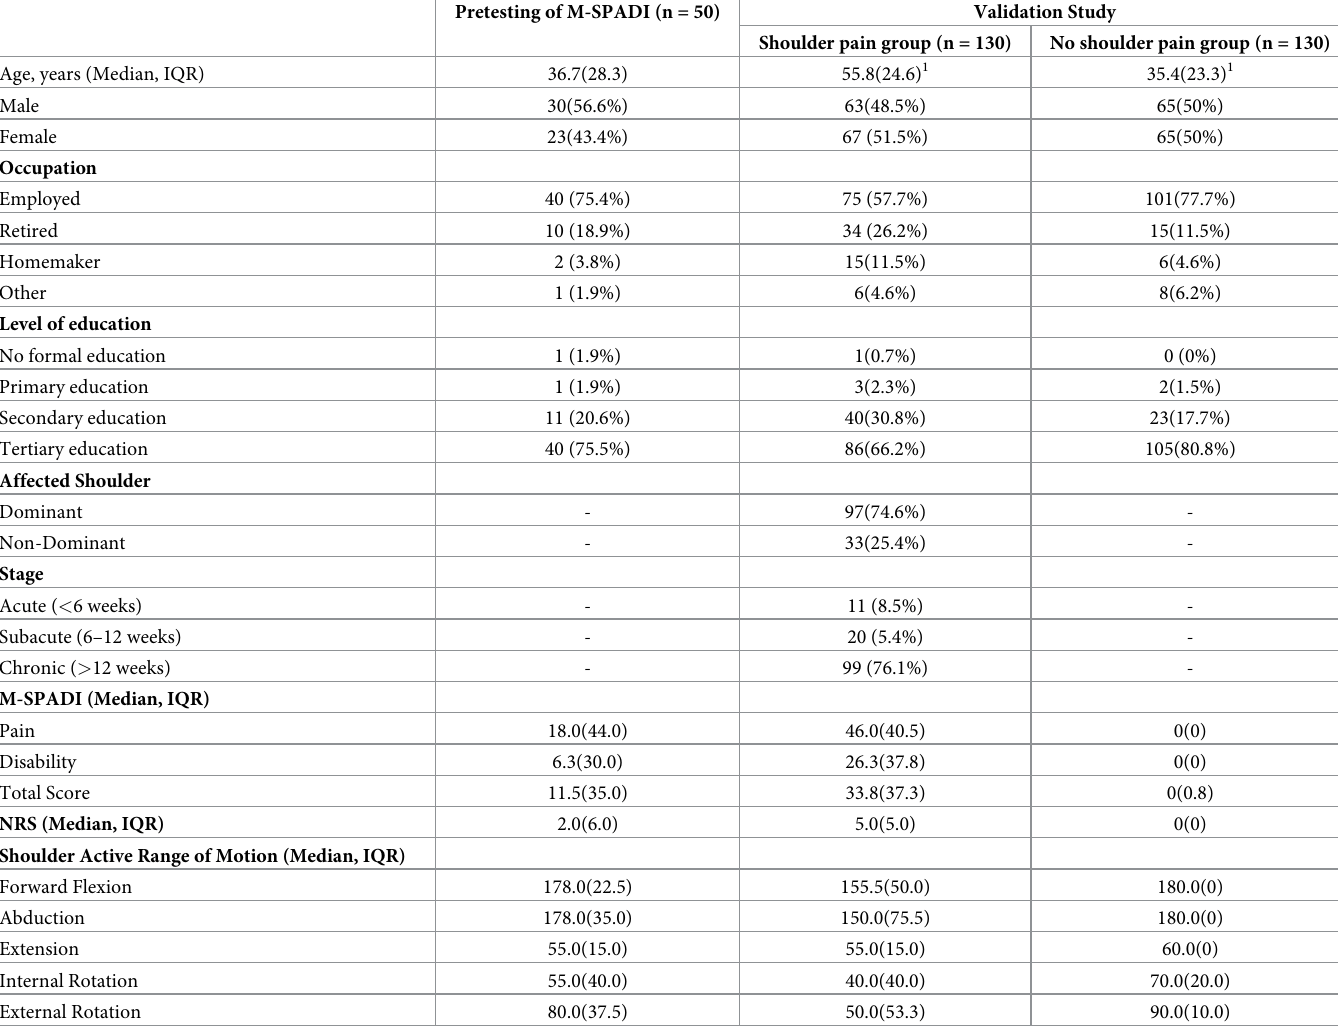
Table 1. Participant demographic characteristics and descriptive statistics of M-SPADI, NRS, and shoulder active range of